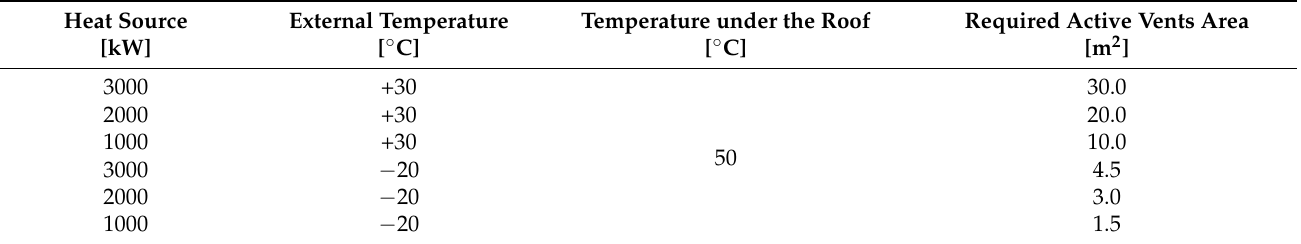
Table 4. The required vents area for keeping under the turbine house’s roof temperature below 50 ◦ C in standard conditions.